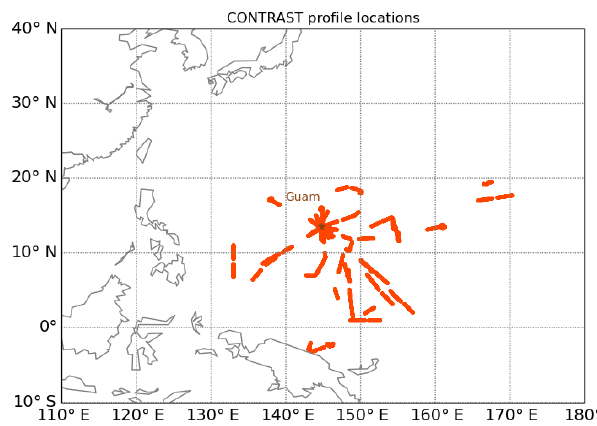
Figure 1. Profiles extracted from the CONTRAST flights during the